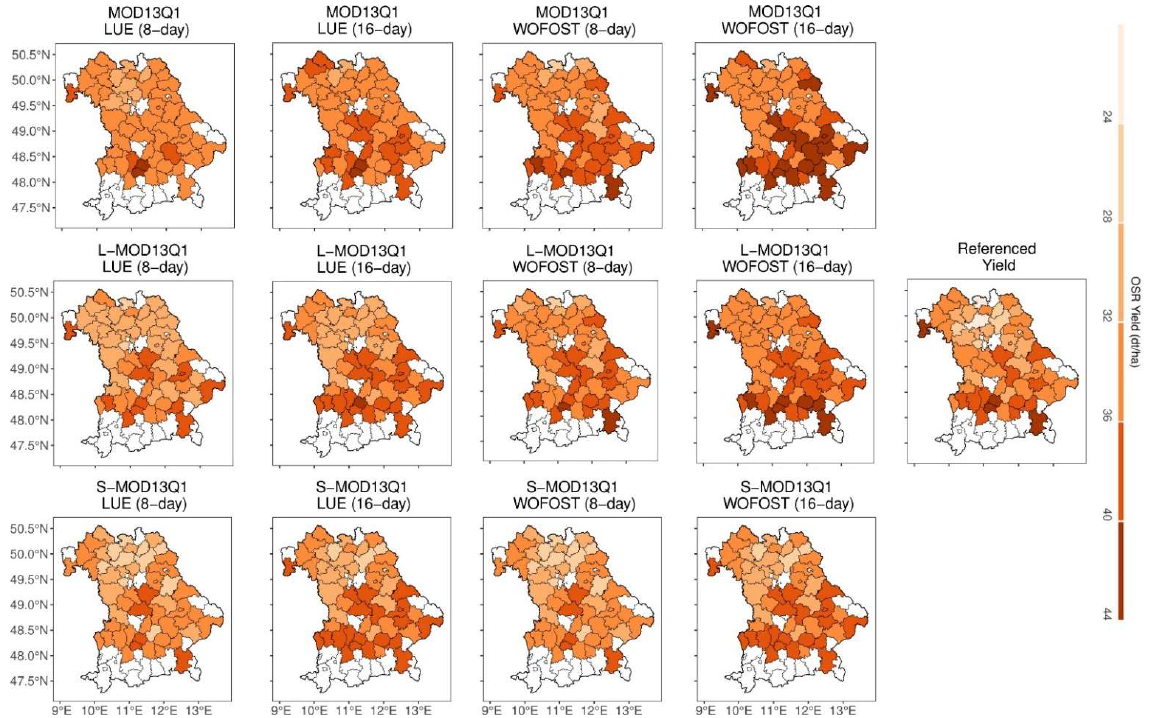
Figure 12. Spatial distribution of referenced yields and predicted yields for OSR using MOD13Q1 (8 and 16 days), L-MOD13Q1 (8 and 16 days), and S-MOD13Q1 (8 and 16 days) with LUE and WOFOST models for the state of Bavaria. The white colour represents no data available. A detailed